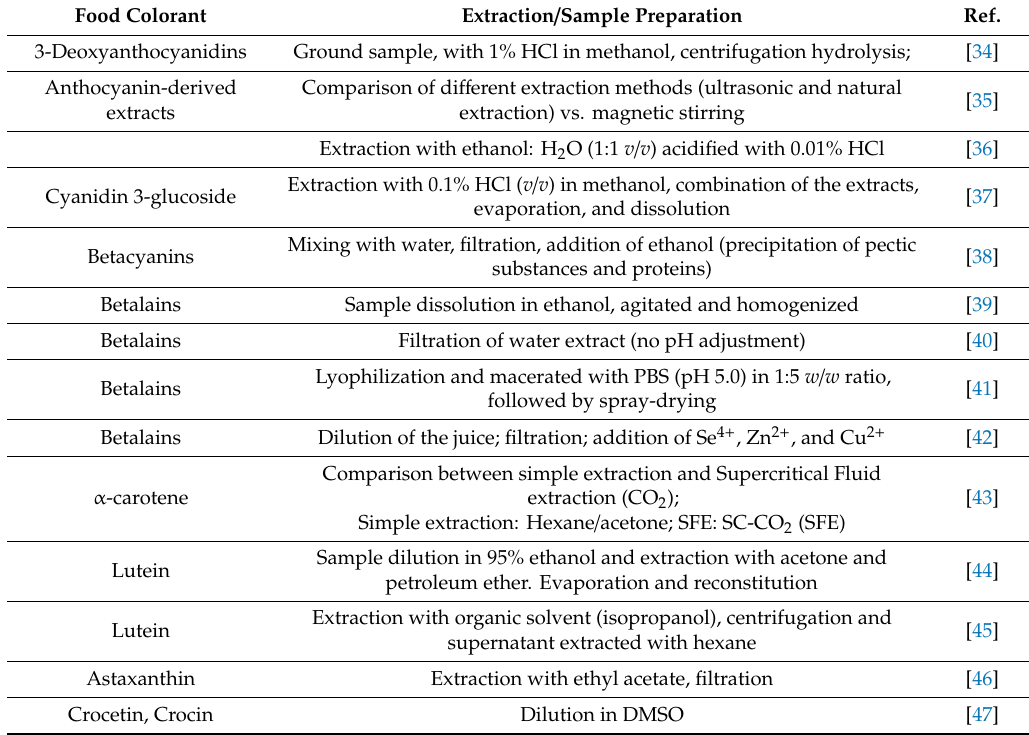
Table 2. Sample preparation techniques for the analysis of natural food colorants in food products. Food Colorant Extraction / Sample